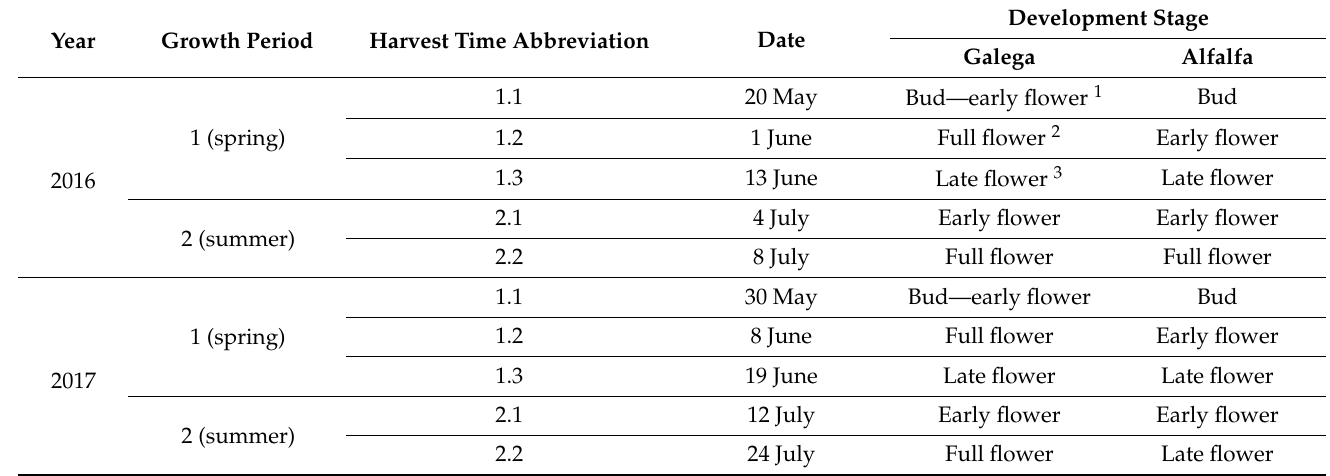
Table 2. Harvest times and development stages of galega and